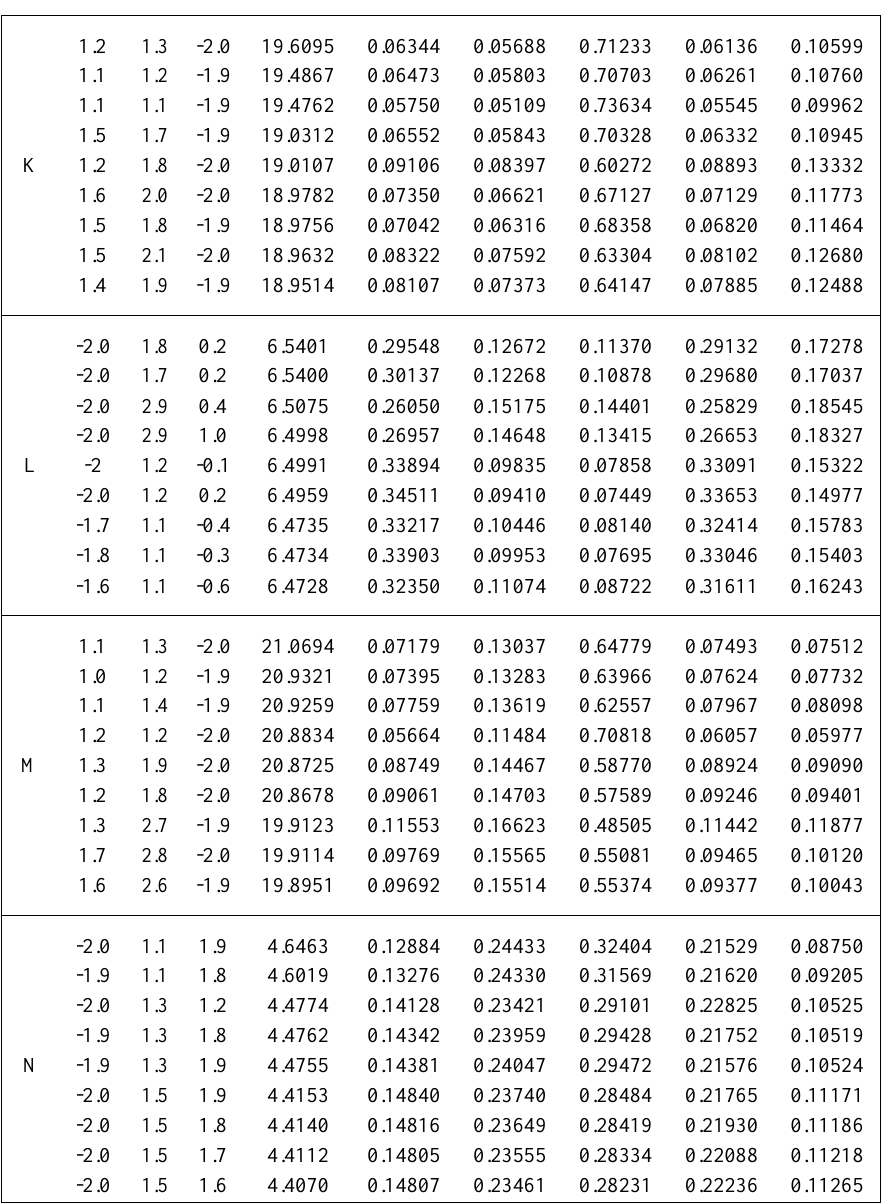
Table 4. The best wealth 𝑆 2500 obtained after 2500 trading days by running the universal portfolio generated by rational functions (11) over the data set J, K, L, M, N for selected value of 𝜂 , 𝜉 , 𝑐 1 , 𝑐 2 and the final portfolios after 2500 trading days 𝒃 2501 are listed.